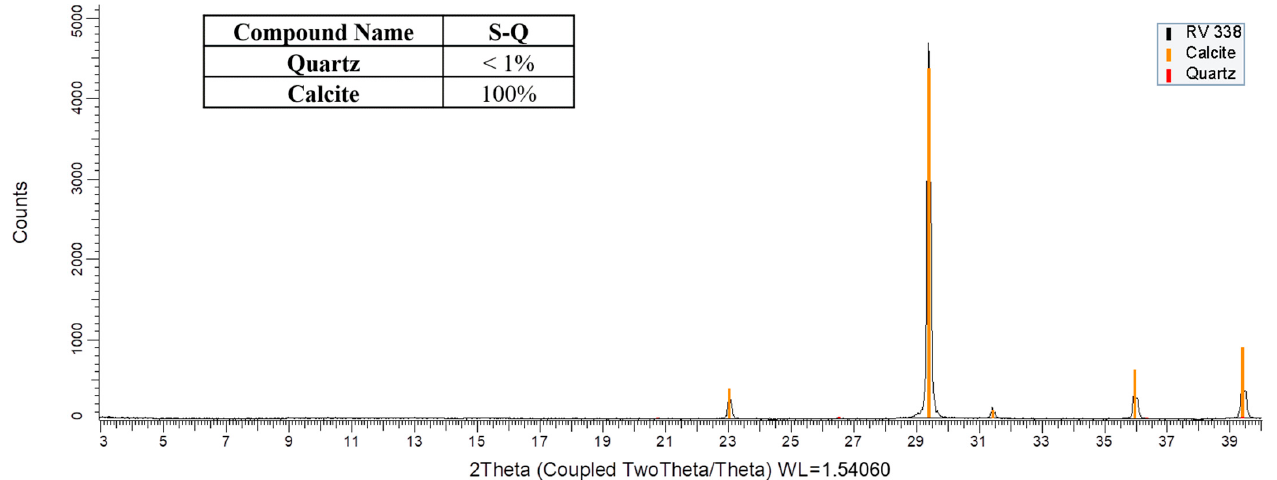
Figure 1. X-ray diffraction analysis of the original rock.